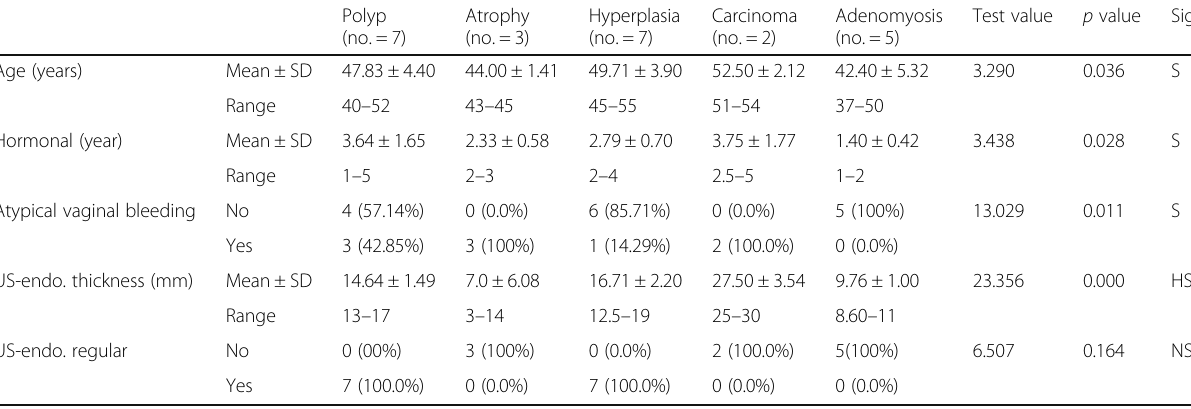
Table 6 Type of pathology with different variables